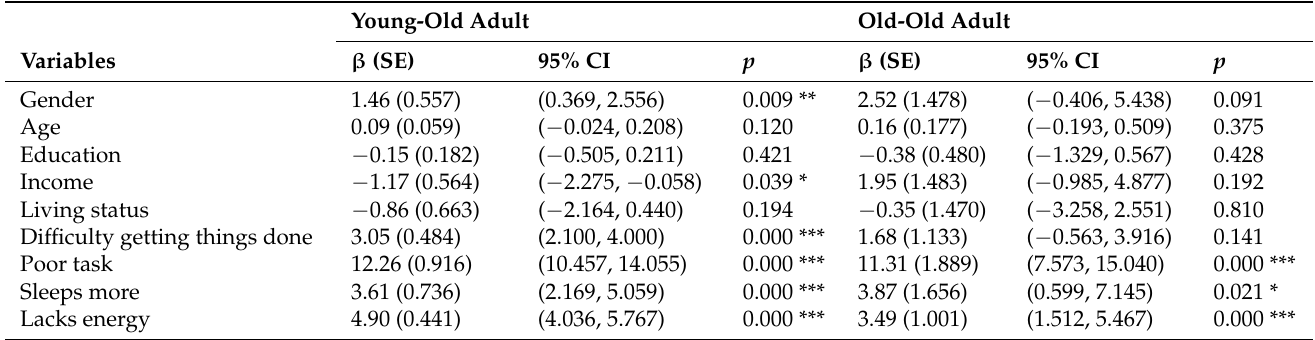
Table 4. Adjusted general linear regression for factors associated with SCD in age